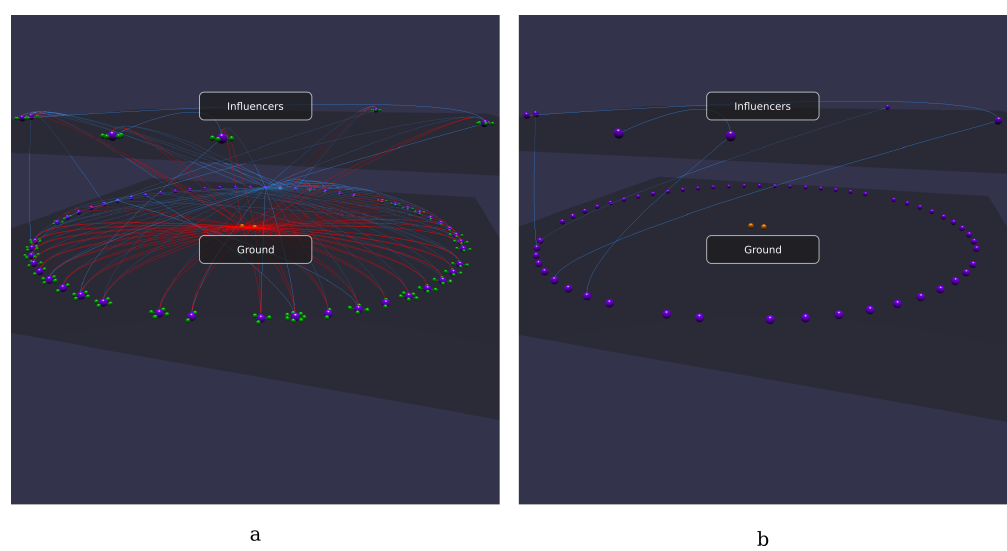
Figure 11. Use Case #2, Question 1: A semantic plane showing the influencers, placed above the semantic plane with the rest of the KB ( a ). Hiding unnecessary edges produces a more effective visualization ( b